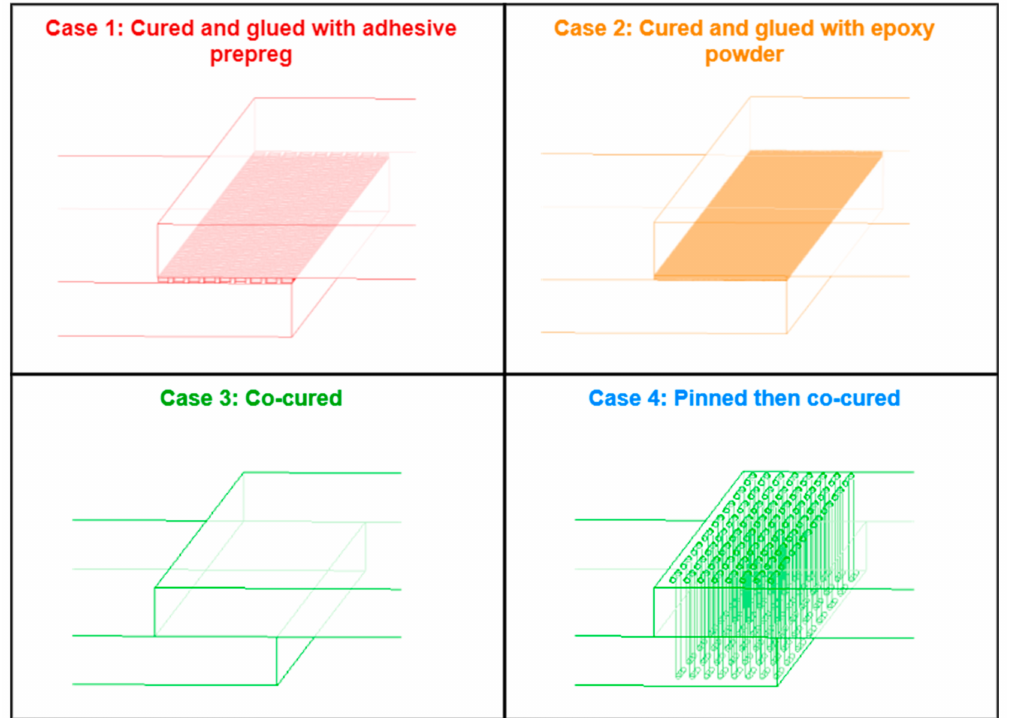
Figure 8. Schematics of the four sets of lap shear samples